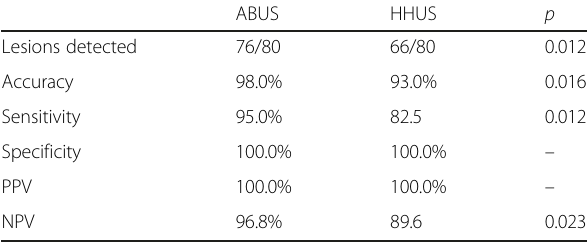
Table 2 The comparison between the numbers of patients with lesion detected by mammography alone and with the addition Table 1 The comparison between ABUS and HHUS in lesion of ABUS. t test was used to compare in between with p detection as regards the number of patients. t test was used to compare in between with p value < 0.05 considered significant ABUS Lesions detected